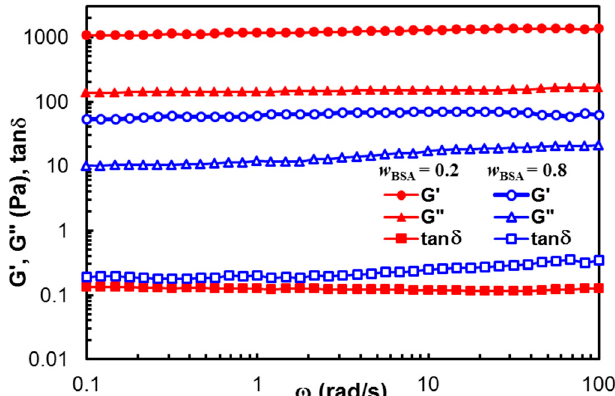
Figure 2. Viscoelastic parameters as a function of oscillation frequency, for hybrid hydrogels with w BSA = 0.2 (full red symbol) and w BSA = 0.8 (empty blue symbol) at 37 °C.